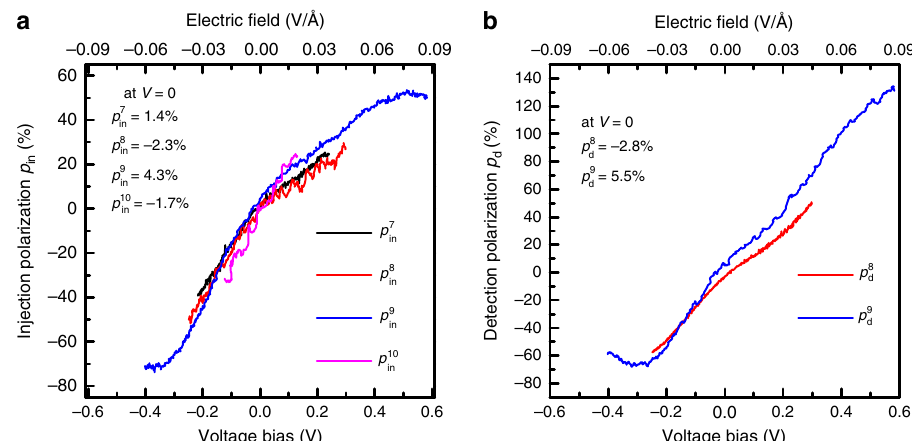
Fig. 4 Differential spin-injection ( p in ) and detection ( p d ) polarizations of the cobalt/bilayer-hBN/graphene contacts. a Differential spin-injection polarization p in of four contacts with 2L-hBN tunnel barrier, as a function of the DC voltage bias V . Top axis represents the corresponding electric- fi eld ( = V / t hBN , t hBN ≈ 7 Å, the thickness of 2L-hBN barrier) induced across the Co/2L-hBN/graphene contacts. Note that the Δ R nl used to calculate p 8 is obtained from a different data set. b Differential spin-detection polarization p d of contacts 8 and 9 as a function of DC voltage bias V applied across the detector, while the injector bias is fi xed at I in = + 20 μ A. The insets in a and b show p in and p d of contacts at zero bias, respectively. The top x axis in a and b indicates the electric fi eld corresponding to the applied bias across the